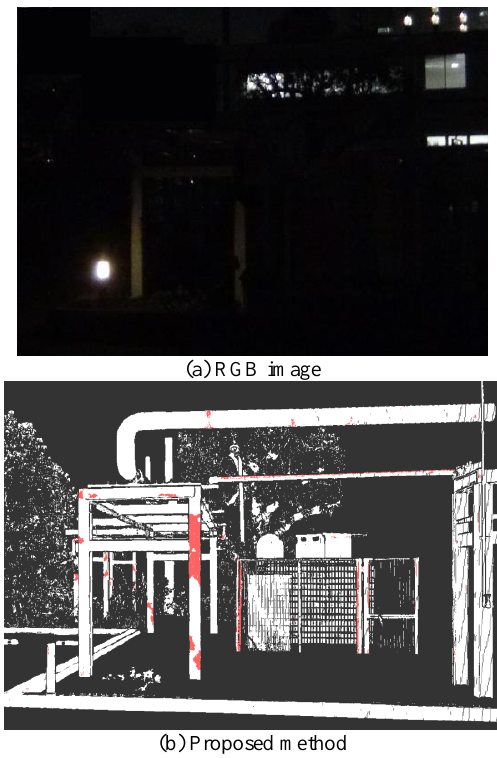
Figure 8. Comparison of RGB image and result of the proposed method. Both images were captured at night.